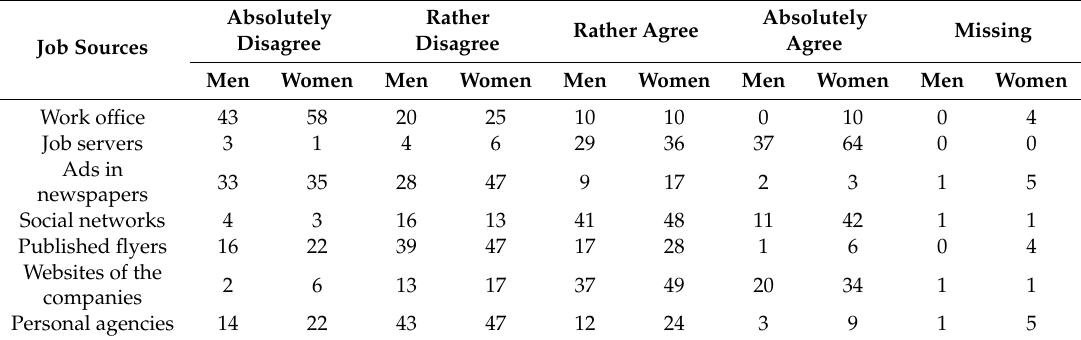
Table 1. Usage of job sources according to the gender of applicants.